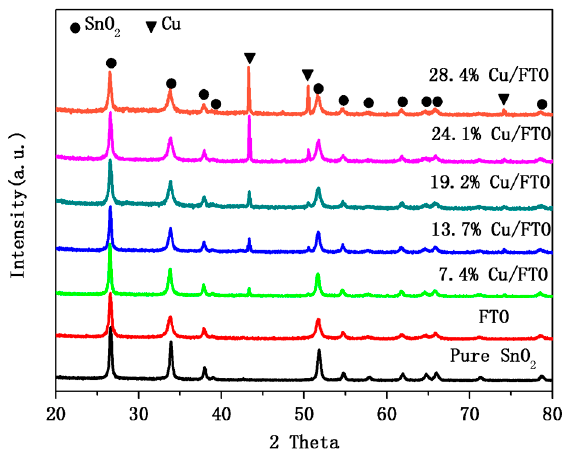
Figure 1. XRD (X ‐ ray diffraction) patterns of pure SnO 2 , FTO (Fluorine ‐ doped tin oxide), and Figure 1. XRD (X-ray diffraction) patterns of pure SnO 2 , FTO (Fluorine-doped tin oxide), and Cu/FTO Cu/FTO samples with different contents of Cu. samples with different contents of